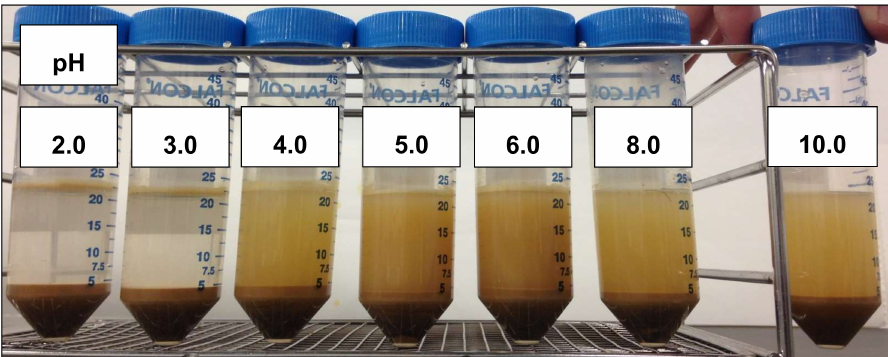
Figure 5. Solutions after adjusting solution pH at 2.0, 3.0, 4.0, 5.0, 6.0, 8.0, and